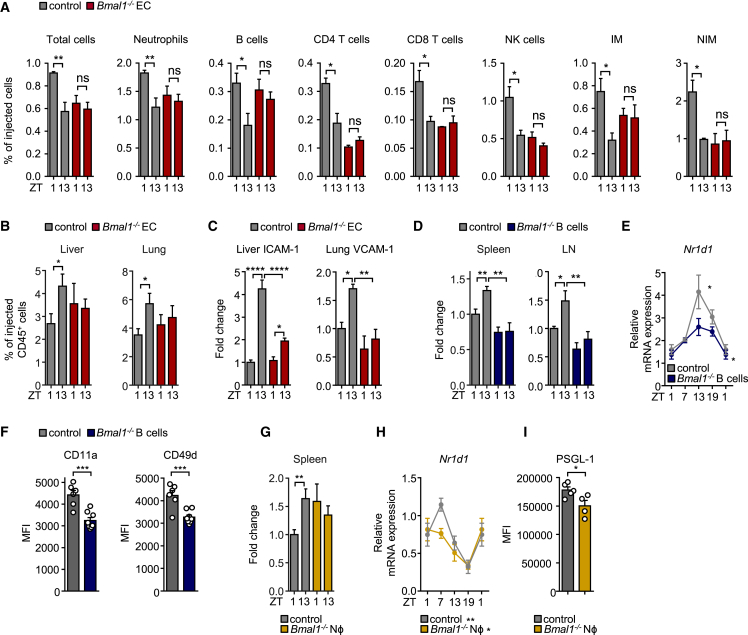
Lineage-Specific Clock Deficiency Ablates Migration Rhythms(A) Numbers of adoptively transferred donor cells present in the blood of control recipients or recipients with Bmal1-deficient endothelial cells 1 hr after transfer at ZT1 and ZT13 (n = 3 or 4 mice; unpaired Student’s t test).(B) Adoptive transfer of donor cells to the liver and lung of control recipients or recipients with Bmal1-deficient endothelial cells 1 hr after transfer at ZT1 and ZT13 (n = 5 mice; unpaired Student’s t test).(C) Expression of endothelial cell ICAM-1 and VCAM-1 in liver and lung of control mice and mice with Bmal1-deficient endothelial cells at ZT1 and ZT13 (n = 4–7 mice; one-way ANOVA).(D) Adoptive transfer of control or Bmal1-deficient B cells to the spleen and lymph node of wild-type recipients 1 hr after transfer at ZT1 and ZT13 (n = 6 mice; unpaired Student’s t test).(E) qPCR analysis of N1rd1 mRNA expression in isolated control and Bmal1-deficient B cells (n = 3 mice; one-way ANOVA).(F) CD11a and CD49d expression on control and Bmal1-deficient B cells in blood at ZT13 (n = 8 mice; unpaired Student’s t test).(G) Adoptive transfer of control or Bmal1-deficient neutrophils to the spleen of wild-type recipients 1 hr after transfer at ZT1 and ZT13 (n = 6 mice; unpaired Student’s t test).(H) qPCR analyses of N1rd1 mRNA expression in isolated control and Bmal1-deficient neutrophils (n = 3 mice; one-way ANOVA).(I) PSGL-1 expression on control and Bmal1-deficient neutrophils in blood at ZT13 (n = 4 or 5 mice; unpaired Student’s t test).∗p < 0.05, ∗∗p < 0.01, ∗∗∗p < 0.001. All data are represented as mean ± SEM. ns, not significant. See also Figure S6.